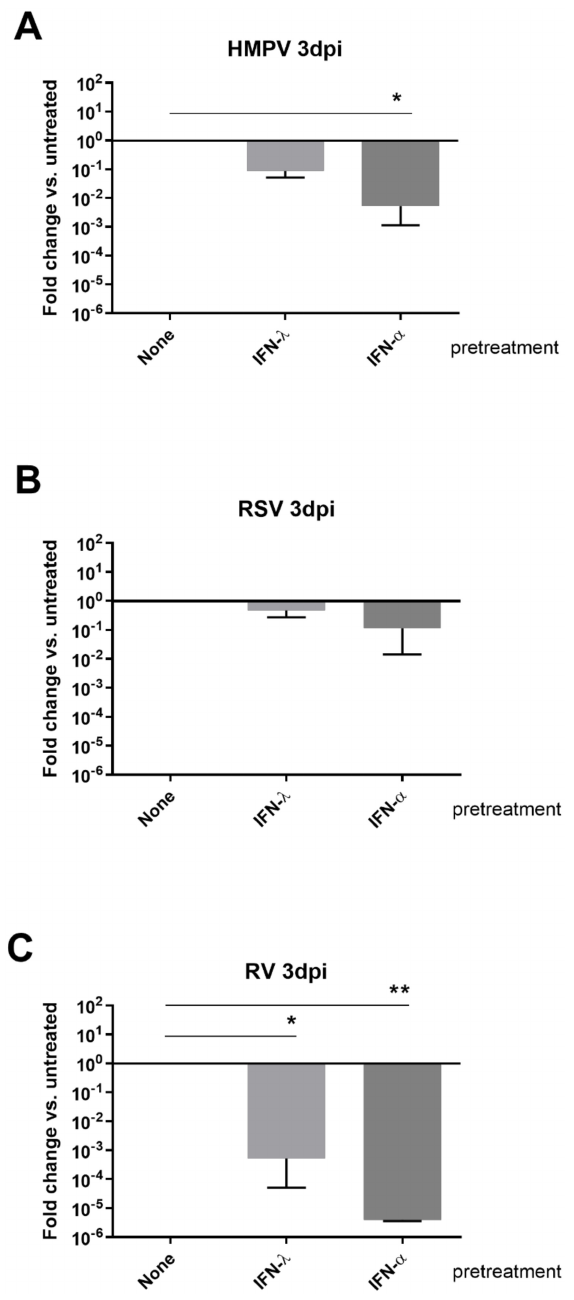
Figure 4. Differential sensitivity of pneumoviruses to type I and type III IFN treatments. Epithelial tissues were treated with 5 ng/mL IFN- λ (type III) or 1000IU IFN- α (type I) and infected 24 h later with HMPV ( A ), RSV ( B ), or RV ( C ). Tissues were then continuously exposed to IFNs for 3 days as described in the material and methods. Viral replication was quantified by RT-qPCR from apical samples collected at 3 dpi from epithelial tissues. Fold changes in viral replication relative to untreated tissues are represented in decimal logarithm. Statistical significance calculated using two-way ANOVA, N = 3, was shown (** p < 0.01 and * p <